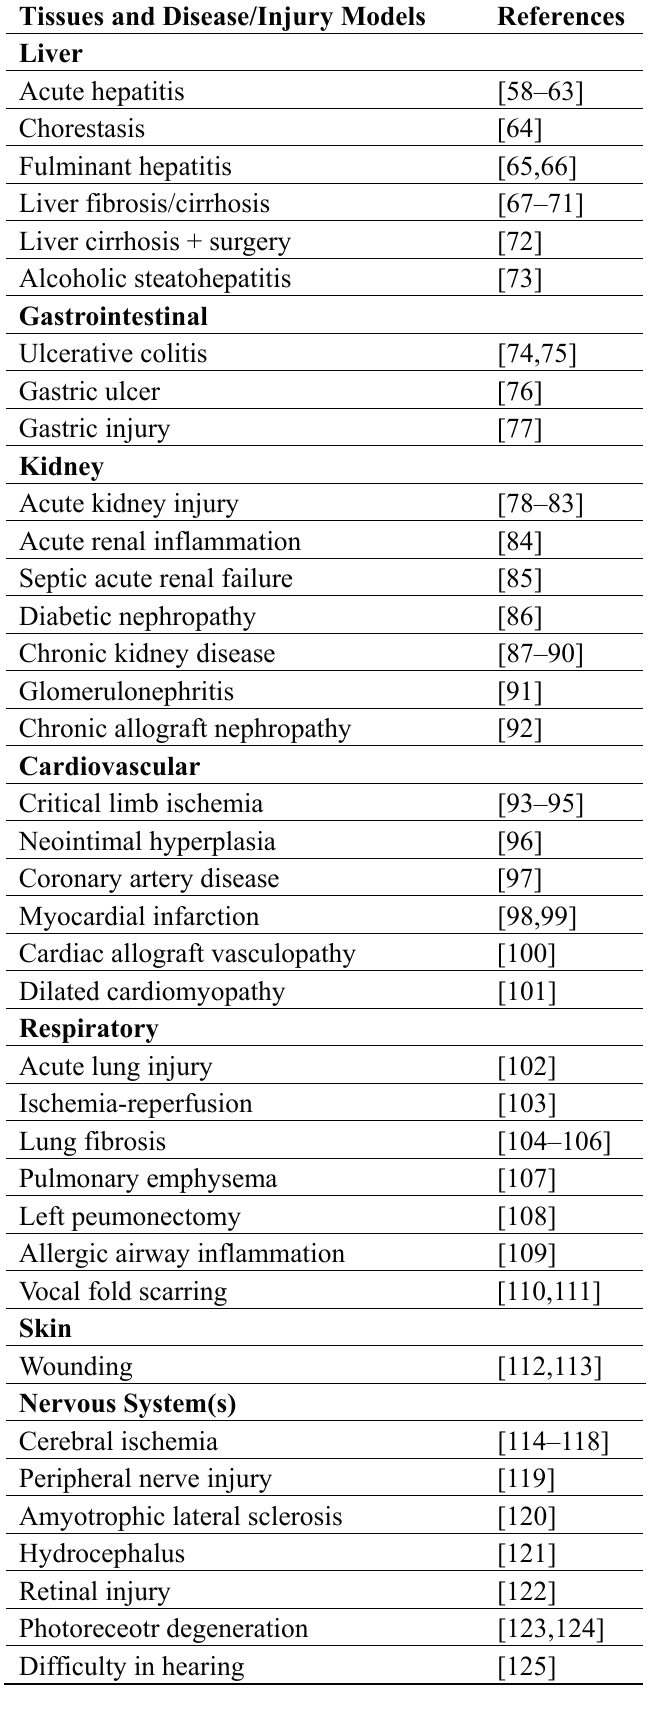
Table 2. Therapeutic approaches with recombinant HGF protein in various disease models. Tissues and Disease/Injury